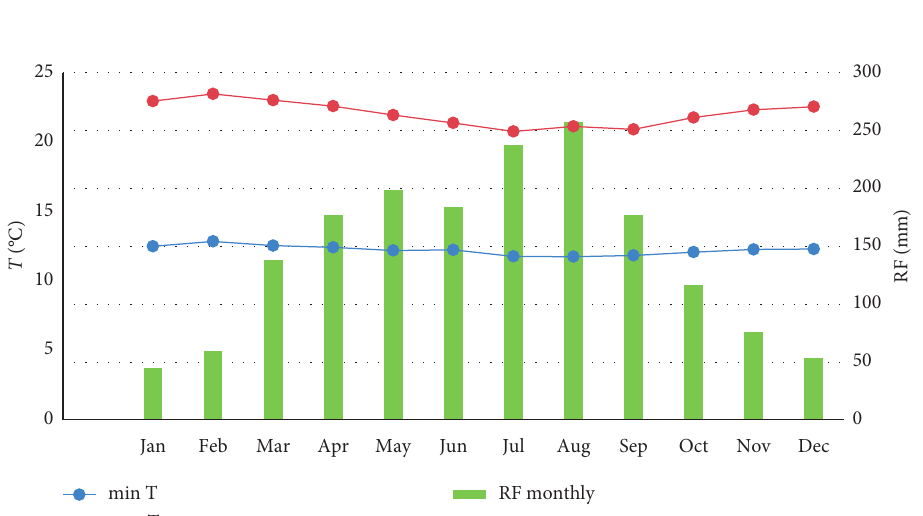
Figure 1: Map of study area.